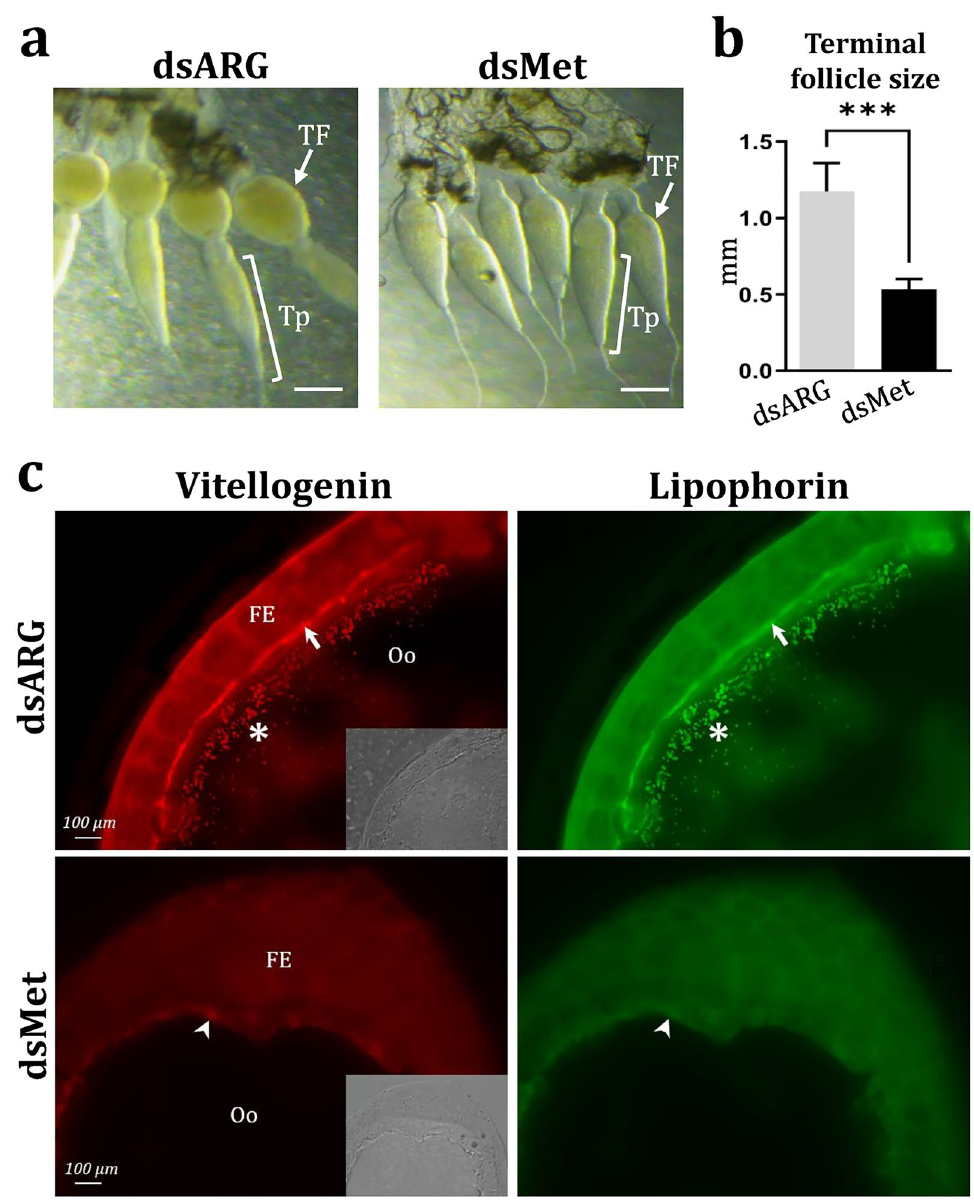
Figure 5. Effect of DmaxMet gene silencing on ovarian development. ( a ) Representative ovarian tissue showing terminal follicles from insects treated with either dsARG (control) or dsMet, two days after blood meal. ( b ) Terminal follicle size from dsRNA-treated insects. The results are shown as mean ± SD of three independent experiments and included samples from insects processed individually ( n = 4). The statistical analyses were performed using Student’s t-test (*** P < 0.001). ( c ) Effect of dsMet and dsARG treatment on Vg and Lp uptake by developing oocytes. Positive signal for Vg (red) and Lp (green) observed in the perioocytic space and oocyte membrane (arrows) as well as in the oocytes (asterisks) of dsARG-treated females (controls) was decreased or faintly detected in dsMet-silenced insects. Bars: 100 µm. FE (follicular epithelium); TF (terminal follicle); Tp (tropharium). Similar results were obtained in three independent